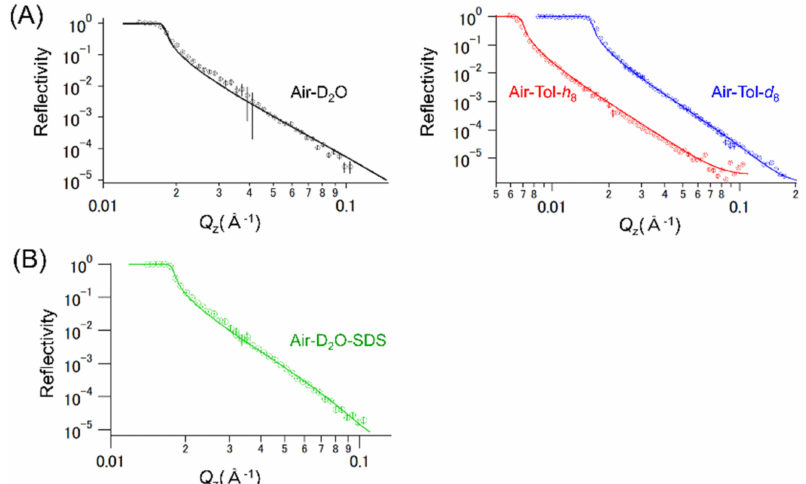
Figure 3. ( A ) NR profiles obtained from the air–organic and air-D 2 O interfaces. ( B ) NR pro- files obtained from the air-D 2 O-SDS sample. RQ z 4 vs. Q z profiles are shown in Figure S2, and the fitting curves and the SLD profiles of the air-D 2 O-SDS sample obtained by different models (Tables S3 and S5) are given in Figure